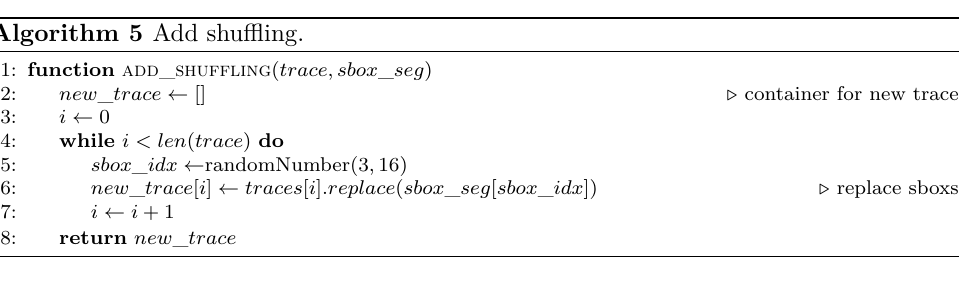
404 Remove Some Noise: On Pre-processing of Side-channel Measurements with Autoencoders